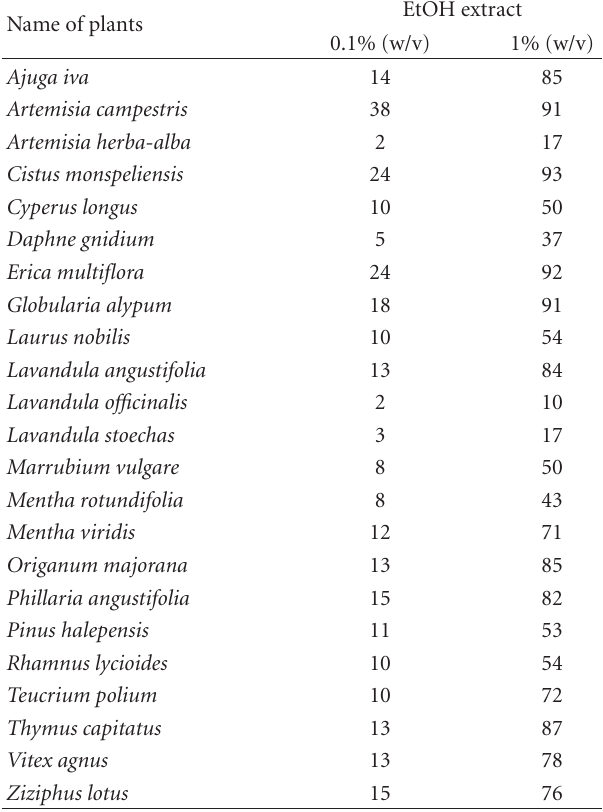
Table 1: E ff ect of antioxidant of 23 plants extracts. The radical 2,2-diphenyl-1-picryhydrazyl (DPPH) was used for measuring the antioxidants. The hot water extract and the ethanol extract were diluted to 10 or 100 times by each solution. The values of antioxidant were calculated by the following formula: antioxidant (%) = { 1 − (Absorbance 520 (Sample)/Absorbance 520 (Control)) }×